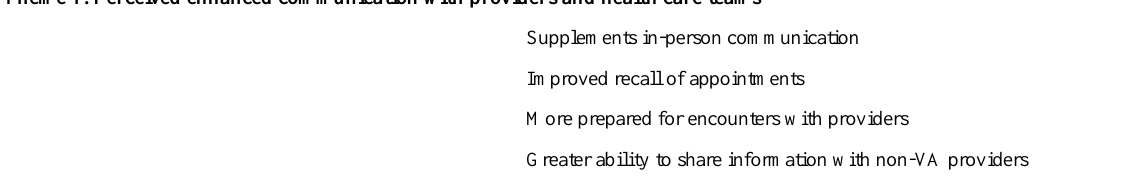
Table 2. Summary of themes on patient experiences with full record access. Theme 1: Perceived enhanced communication with providers and health care